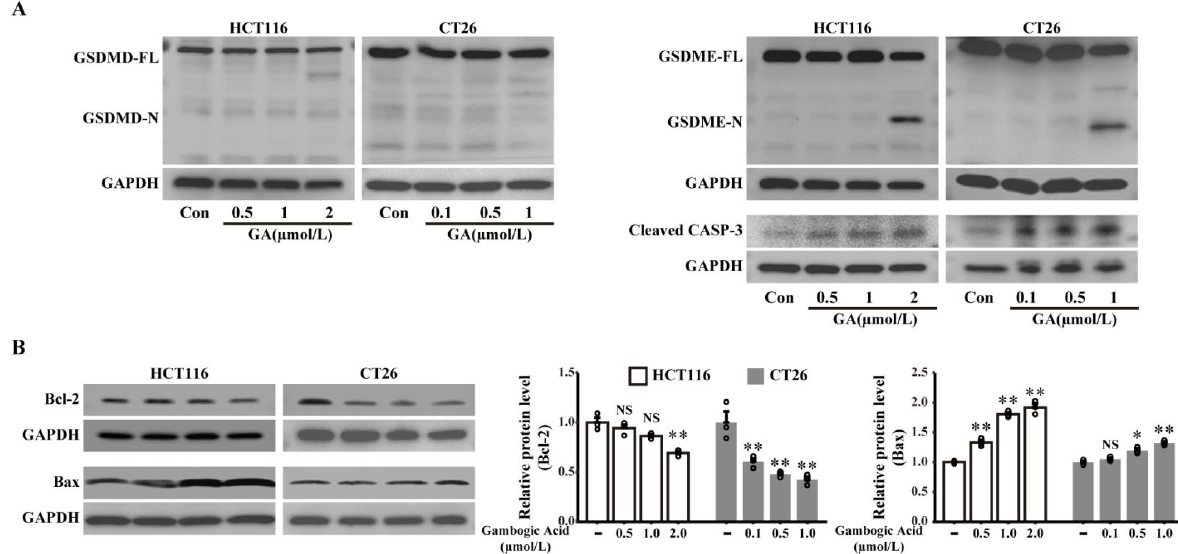
Figure 4. GSDME, rather than GSDMD, was involved in GA-induced pyroptosis in CRC cells. ( A ) Expressions of GSDMD, GSDME, and cleaved caspase-3 in HCT116 and CT26 cells treated